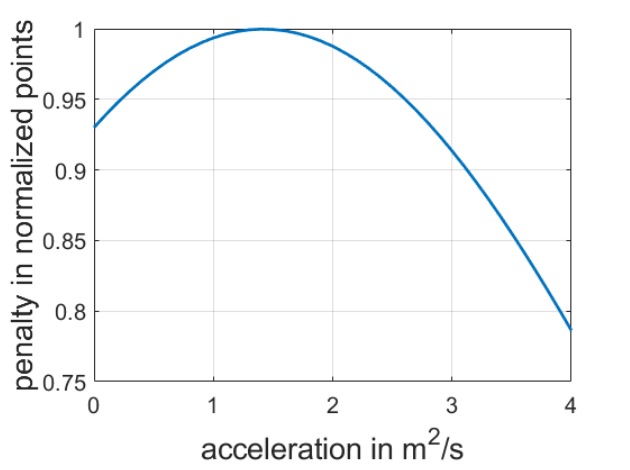
Figure 6. Penalty function, with a a = 1.5 m/s 2 , V = 0 m/s, t = 3 s, V a = 5 m/s, wa = 500, and wd =